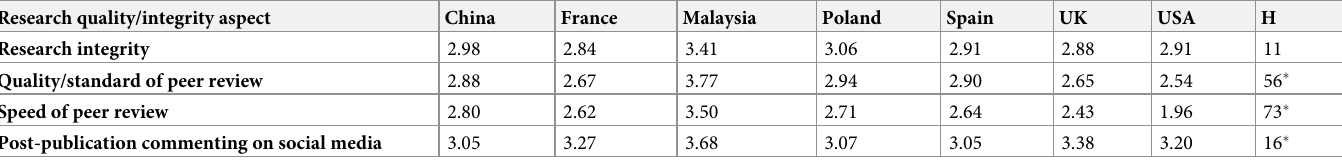
Table 11. Country differences (mean) for impact of the pandemic on research quality and integrity. Research quality/integrity